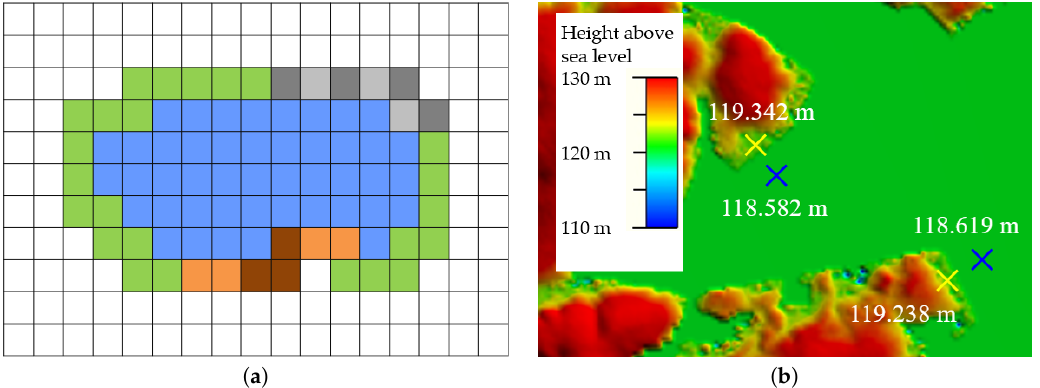
Figure 10. ( a ) Shoreline determination for estimating the predominant shoreline height. Blue are lake pixels, green represents the shoreline close to the lake height, orange and brown pixels mountains or cliffs and gray noisy height. ( b ) Example showing the performance of the lake flattening procedure over Lake Gairdner, Australia. Blue crosses indicate the height of the water body and the yellow crosses the height of dry, unedited land areas, close to the